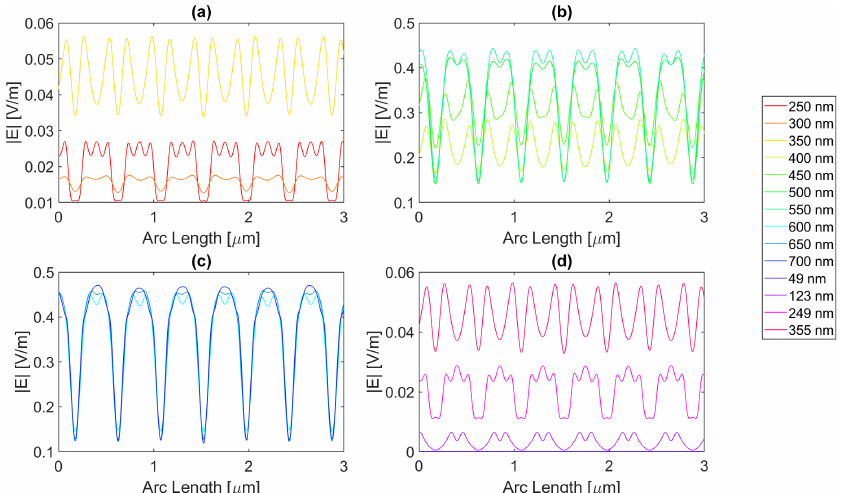
Figure 20. Electric field for the silver triangular nanostructure with a 100 nm base—Probe